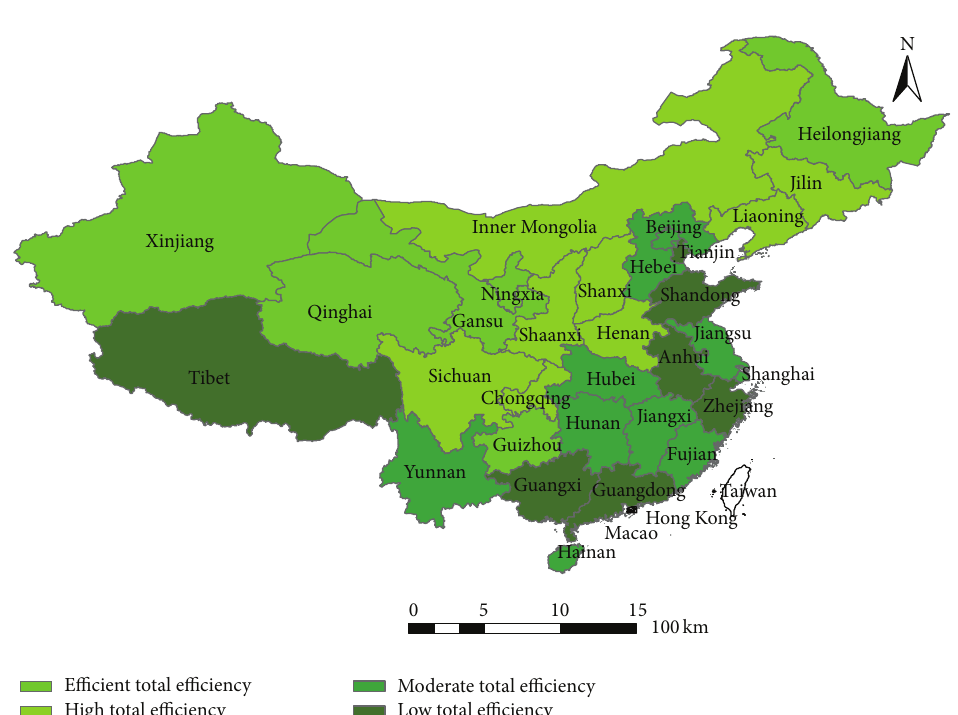
Figure 1: Spatial distribution of total efficiency of intensive agricultural production in China.